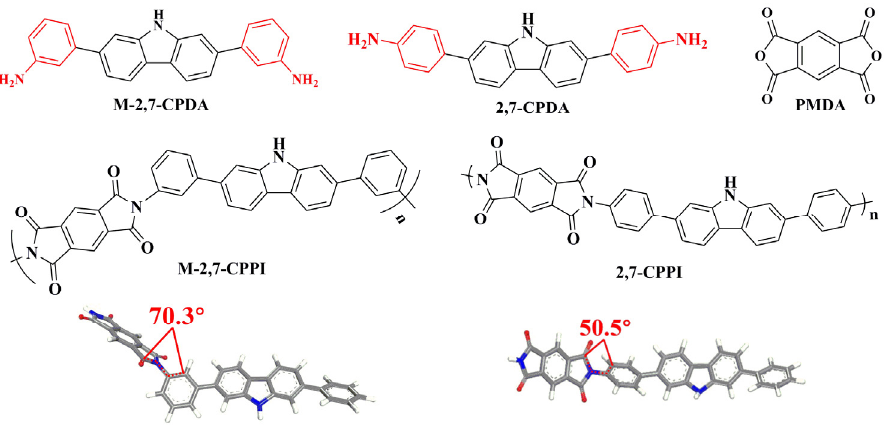
Figure 1. The chemical structures of monomers and the lowest energy conformation of M-2,7-CPPI and 2,7-CPPI repeat units.